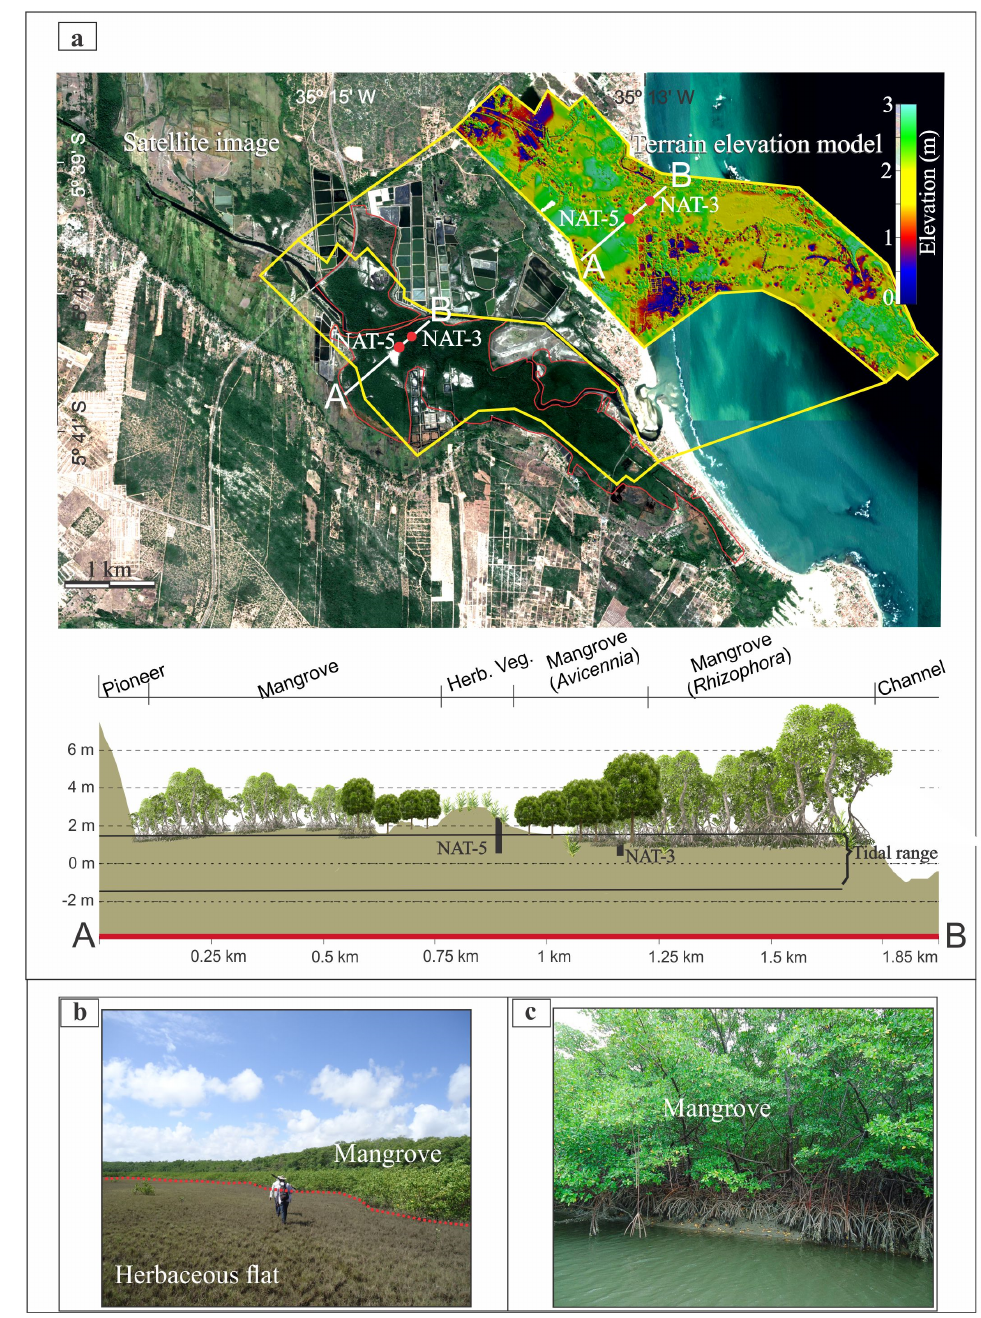
Figure 2. ( a ) Satellite image indicating the mangrove area, the digital terrain model, and the sampling core sites along a topographic profile (A–B) with vegetation units, ( b ) ground photo presenting the transition herbaceous flat and mangrove with Avicennia trees, ( c ) ground photo showing mangrove with Rhizophora trees along a channel.